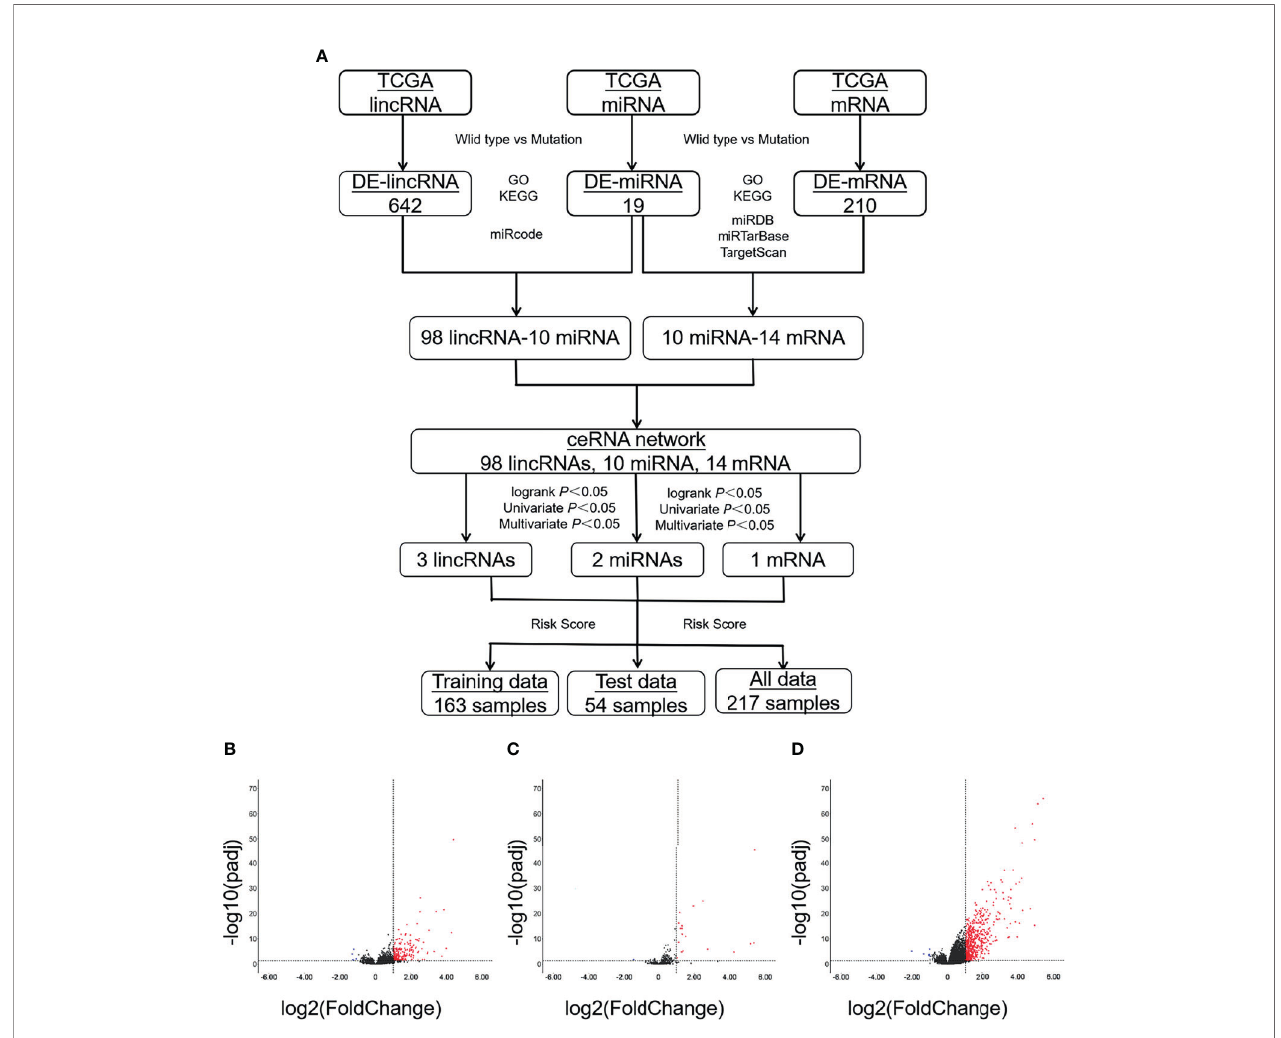
FIGURE 1 | A large number of DE-RNAs are identi fi ed between patients carrying either wild-type or mutant VHL. (A) A diagram showing the work fl ow of the study. (B – D) Volcanic maps showing the distribution of DE-lncRNAs (B) , DE-miRNAs (C) , or DE-mRNAs (D) . Red, blue, and black dots represent those RNAs that are signi fi cantly upregulated, signi fi cantly downregulated, and not signi fi cantly changed, respectively. VHL, Von Hippel – Lindau; DE-RNAs, differentially expressed RNAs; DE-lncRNAs, differentially expressed long non-coding RNAs; DE-miRNAs, differentially expressed microRNAs; DE-mRNAs, differentially expressed messenger